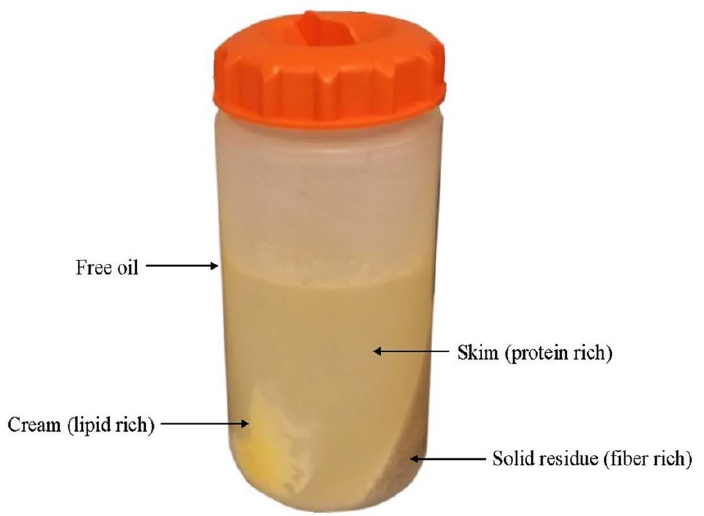
Figure 3. Image of partitioning in aqueous extraction slurry after centrifugation.